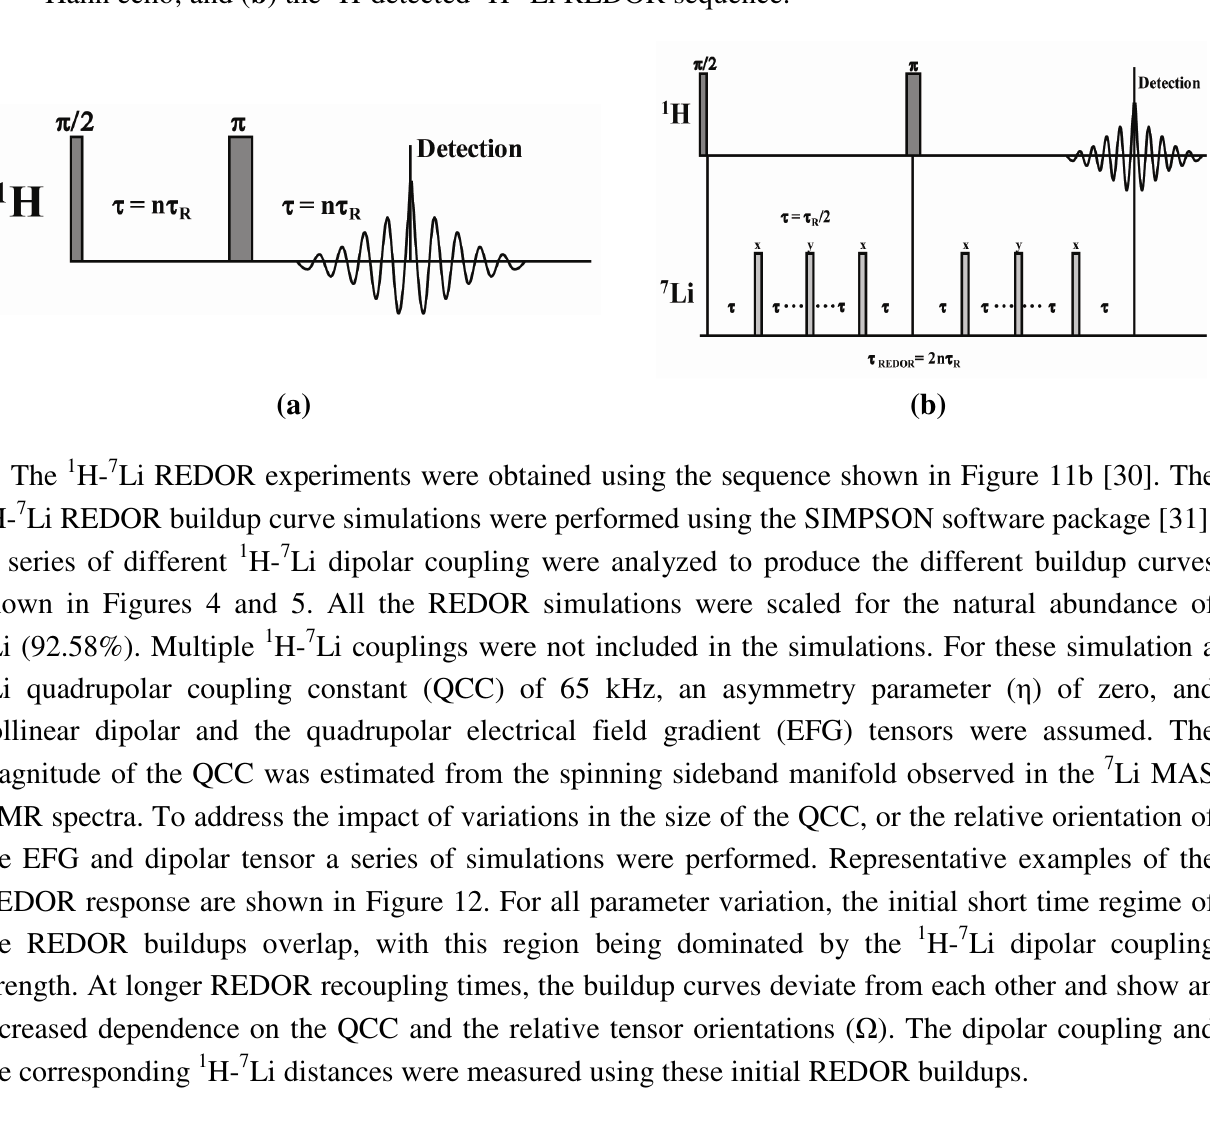
Figure 11. MAS NMR pulse sequences employed including the ( a ) rotor synchronized Hahn echo; and ( b ) the 1 H-detected 1 H- 7 Li REDOR